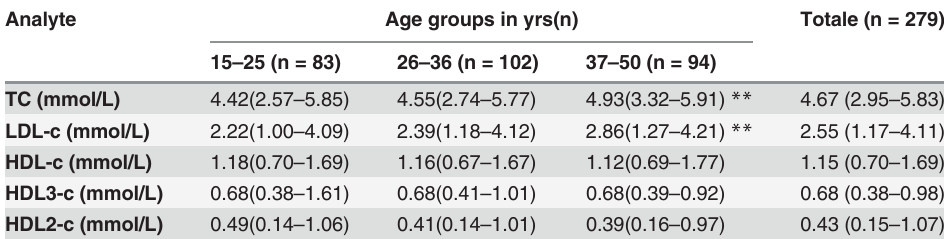
Table 3. Reference Ranges of cholesterol fractions [median (percentiles 2.5 et 97.5)].